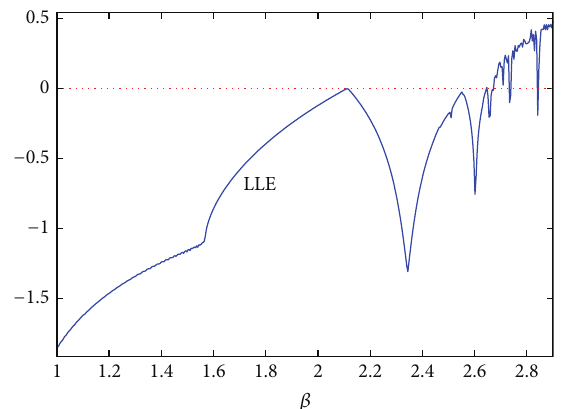
Figure 7: The largest Lyapunov exponent of system (10) for 𝛼 = 2.5 and 𝛽 varying from 1.0 to 2.47